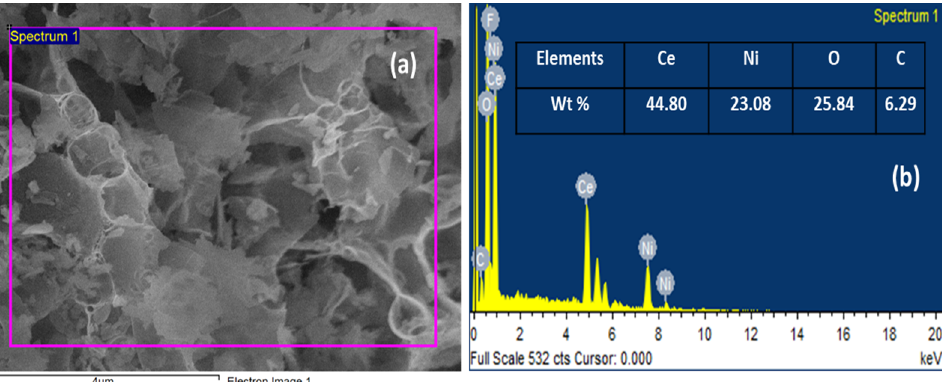
Figure 4. ( a ) SEM image of CeO2/NiO nanocomposite with scan area and ( b ) Energy-dispersive X-ray spectroscopy (EDX) spectrum with a weight percentage of all elements.